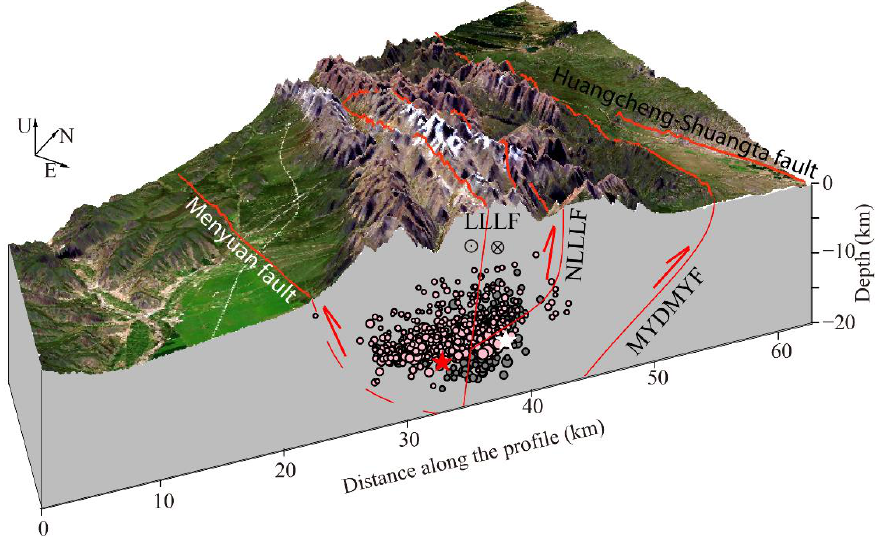
Figure 10. The regional tectonic model illumined by the two Menyuan earthquakes. The profile location is shown in Figure 1b with a blue line. Gray and pink dots represent the aftershock relocations of the 2016 and 2022 Menyuan earthquakes. Red lines show the active faults, and red dashed lines show the inferred fault location.